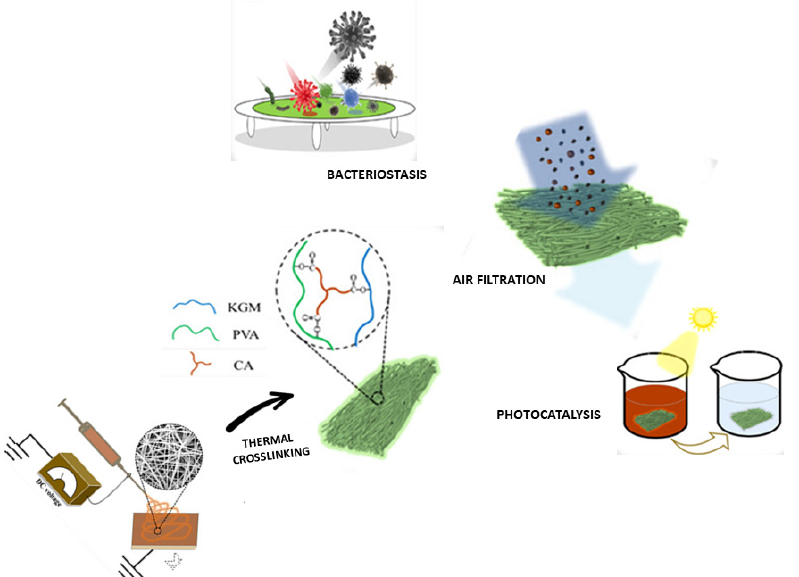
Figure 6. Schematic summary of processing routes based on EFDTs for the fabrication of active particles loaded systems via thermal crosslinking and examples of nanoparticle loaded membranes applications for environmental remediation, i.e., bacteriostasis, air filtration, photocatalysis (adapted from [93]).